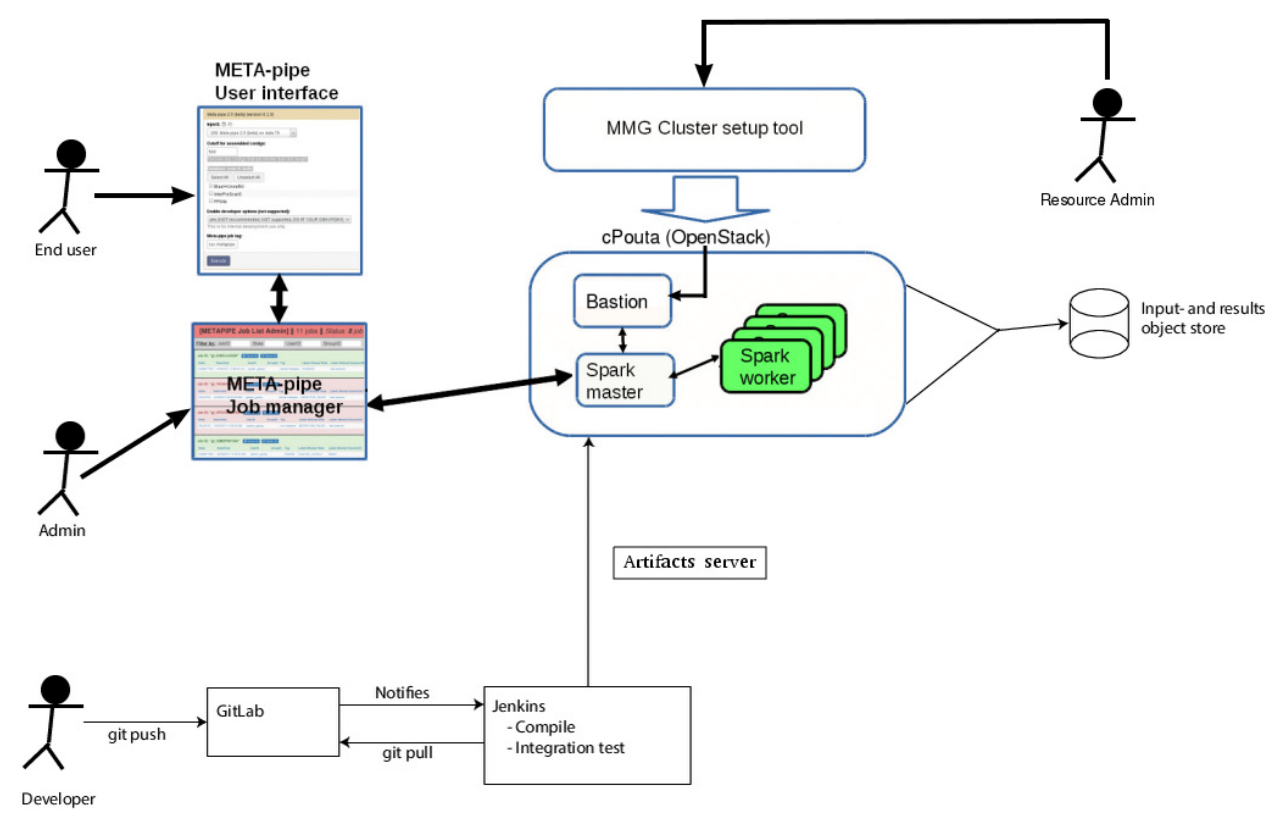
Figure 2. META-pipe deployment. End-users run analyses using the META-pipe web app. The web app is integrated with ELIXIR AAI, so users can authenticate using their home institution username and password. Resource providers use the cluster setup tool to set up an execution manager, on, for example, the cPouta OpenStack cloud, which executes analysis jobs. The execution manager, pipeline, and dependencies are all read from our artifacts server. META-pipe developers use git to maintain the code. Our GitLab is integrated with Jenkins that compiles and runs integration tests and pushes new META-pipe versions to the artifacts server. META-pipe administrators administer all jobs using the META-pipe Job manager